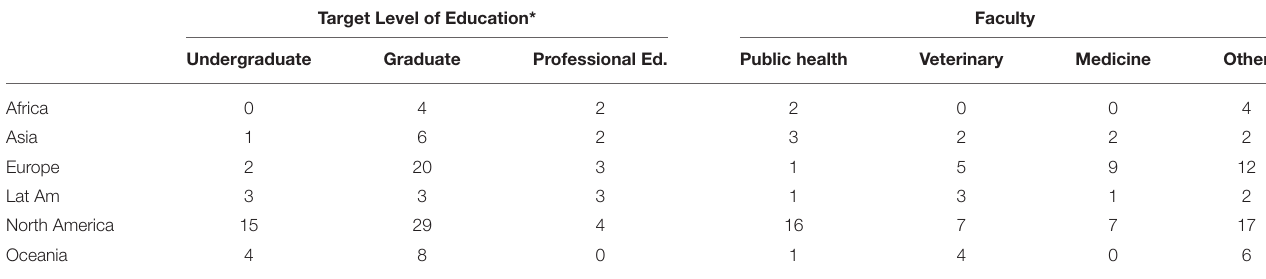
TABLE 1 | Number of educational offerings per region separated according to target level of education and faculty offering the education opportunity. Target Level of